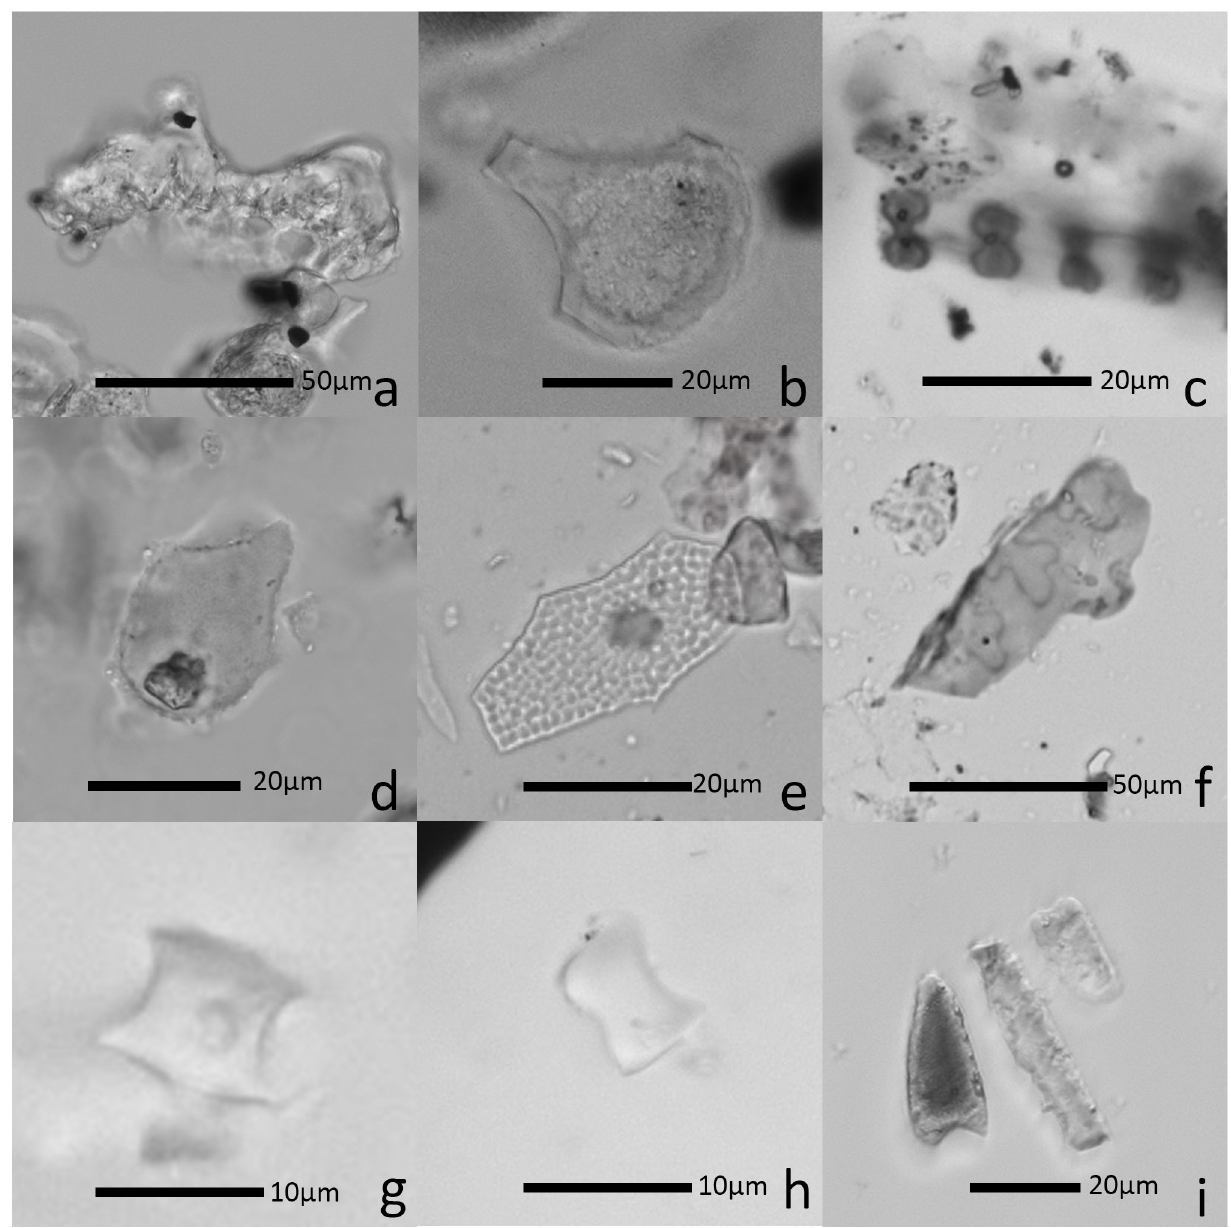
Fig 5. Phytolith morphotypes recovered from flakes from Shangshan and Hehuashan flakes. (a) Double-peak ( Oryza , rice); (b) Oryza -type bulliform ( Oryza , rice); (c) Scooped parallel bilobate (Oryzeae); (d) Reed-type bulliform ( Phragmites ); (e) Sedge achene (Cyperaceae); (f) Articulated quadrilobate (Panicoideae); (g) Rondel (Poaceae); (h) Saddle (Poaceae); (i) Scutiform, elongate sinuate, and rectangular (Poaceae).